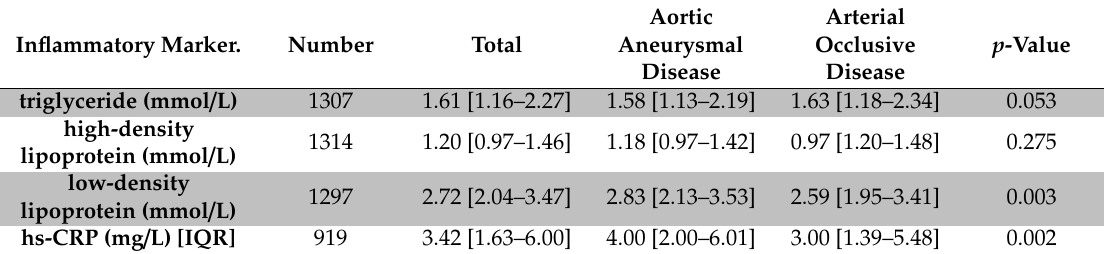
Table 6. Inflammatory markers of patients with aneurysmal or arterial occlusive disease. Abbreviations: hs-CRP: High sensitive C-reactive protein. Data presented in median with inter quartile range.